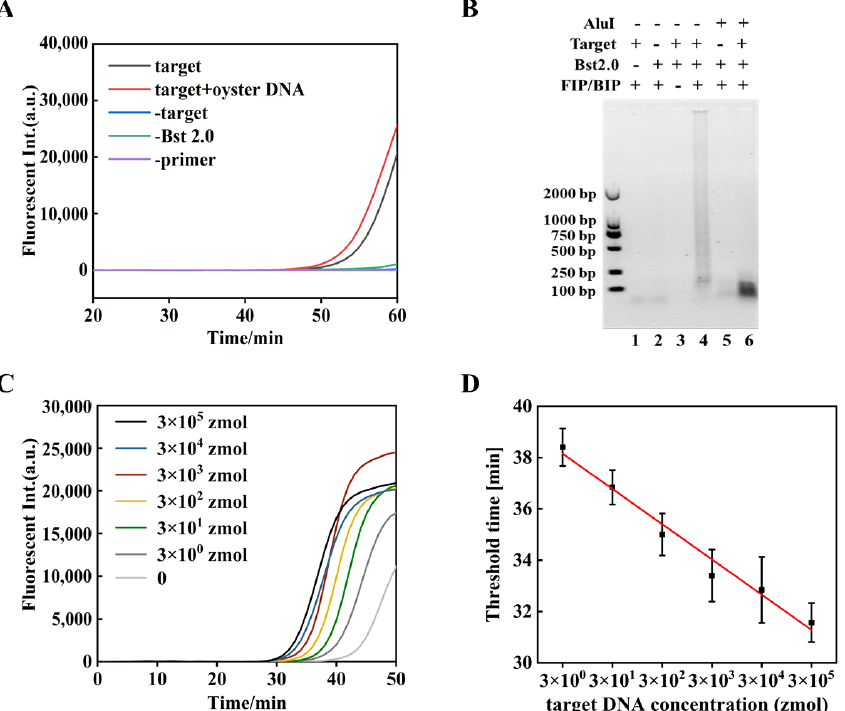
Figure 3. Detection of V. parahaemolyticus by tRCA-lamp. ( A ) Real-time fluorescence analysis. [target DNA] = 3 amol (10 5 copies/μL), [FIP/BIP primers] = 1.6 μmol/L, [dNTP] = 1.4 mmol/L, 1 × SYBR Green II, 3.2 U Bst 2.0 DNA polymerase, 1 × isothermal amplification buffer at 65 °C for 60 min. ( B ) Endpoint product of tRCA-lamp with oyster DNA was digested with Alu I and analyzed on 1% aga-